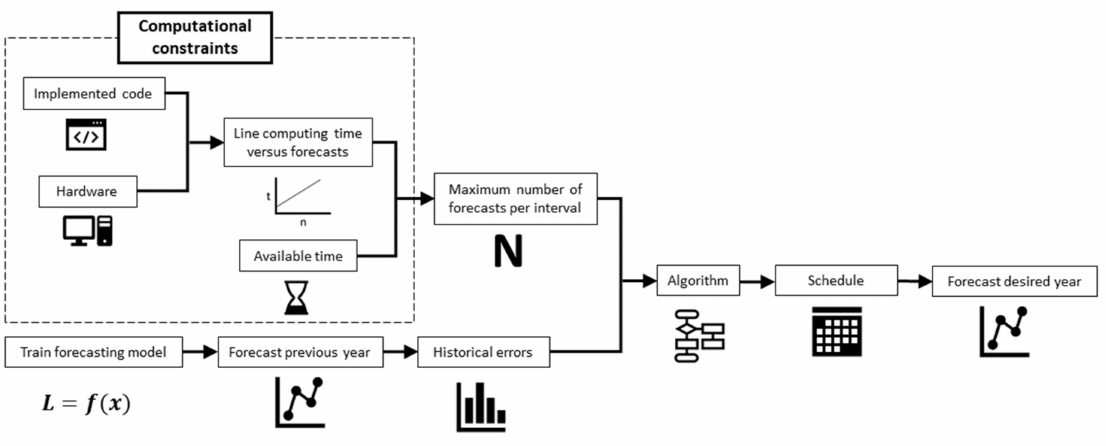
Figure 2. Process